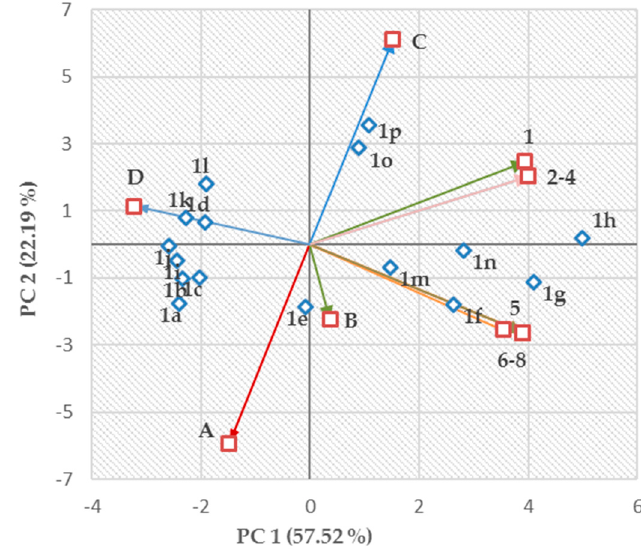
Figure 1. Two-dimensional (2D) score plot (mapping) showing (i) both principal component 1 (PC 1) and 2 (PC 2) scores of compounds 1a – 1p ; (ii) loadings of variables (i.e., variously colored vectors), the assignment (numbering) of which is as follows: A (vector assigned to the variable γ ), B (log ε 2 (Ch-T) ), C (log k w ), D ( IC 50 ), 1 (vector built on log (1 / MIC (M)) values, which were connected with the in vitro testing of compounds 1a – 1p against E. faecalis ), 2 (VRE 368), 3 (VRE 725B), 4 (VRE 342B), 5 (SA 29213), 6 (MRSA SA 3202), 7 (MRSA SA 630), and 8 (MRSA 63718).